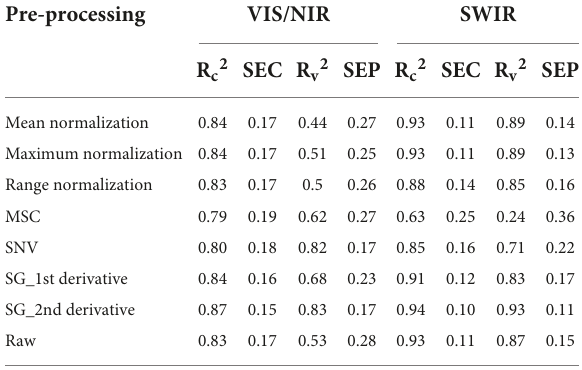
TABLE 1 The reference values of phenolic compounds [mg/g dry weight (DW)] obtained from HPLC analysis. S. No Phenolic compounds